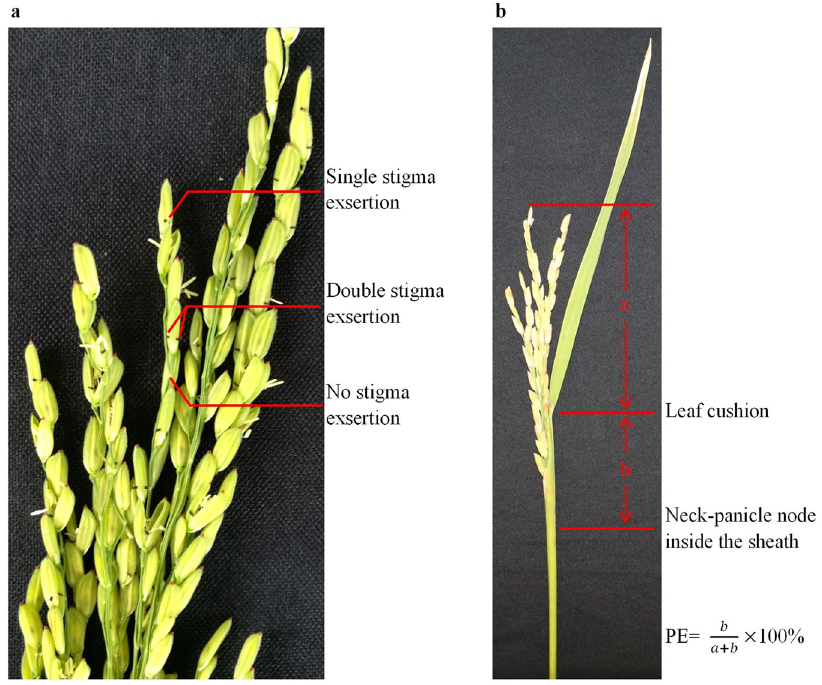
Figure 5. Phenotyping of stigma exsertion and panicle enclosure in this study. ( a ) stigma exsertion. ( b ) panicle